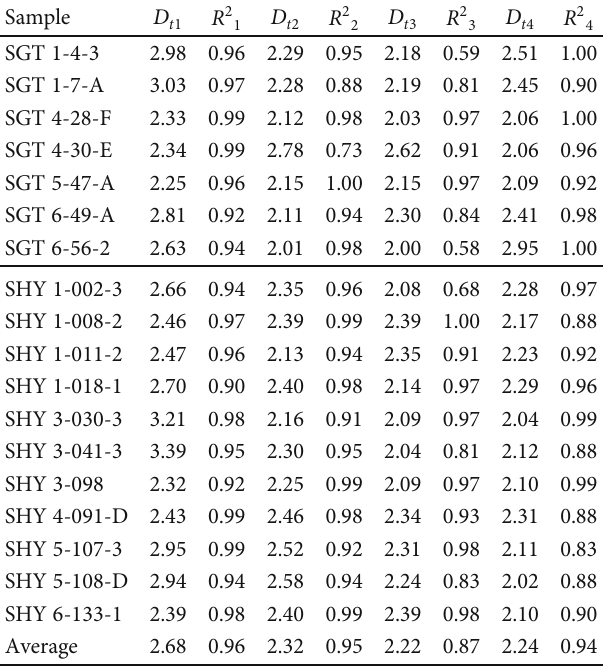
Table 4: Fractal dimensions of the carbonate samples.